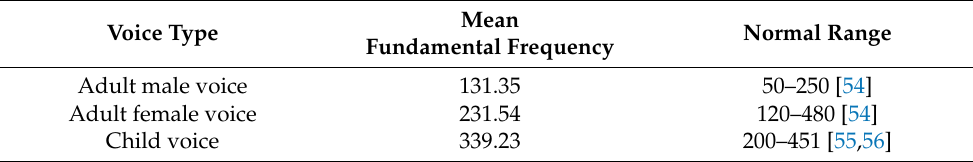
Table 1. Mean fundamental frequencies of voice stimuli.